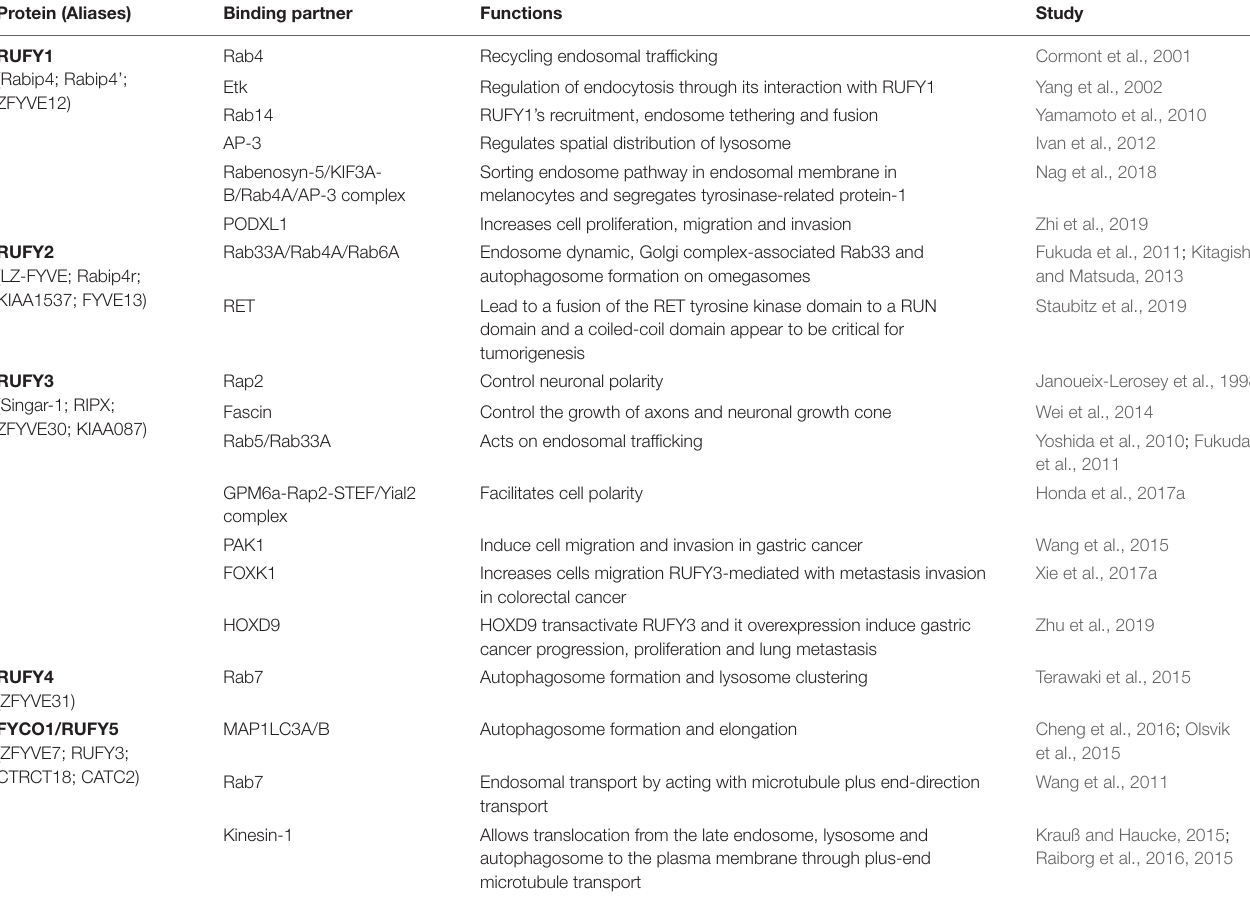
TABLE 1 | Summary of RUFY proteins functional interactions. Protein